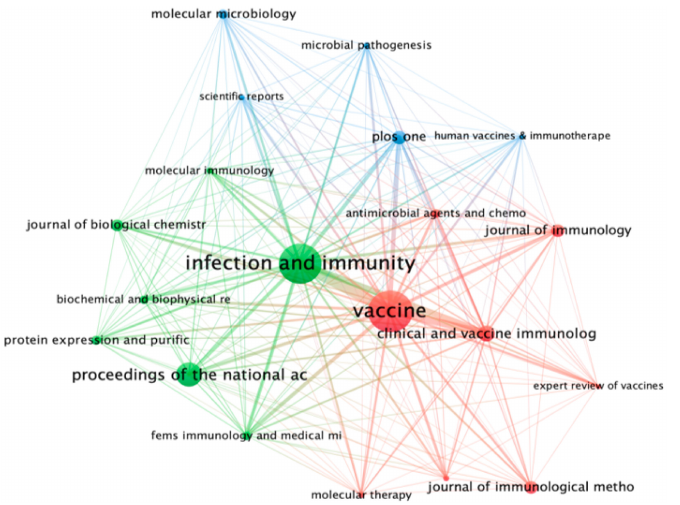
Figure 8. Bibliographic coupling sources network visualization mapping based on the number of citations.